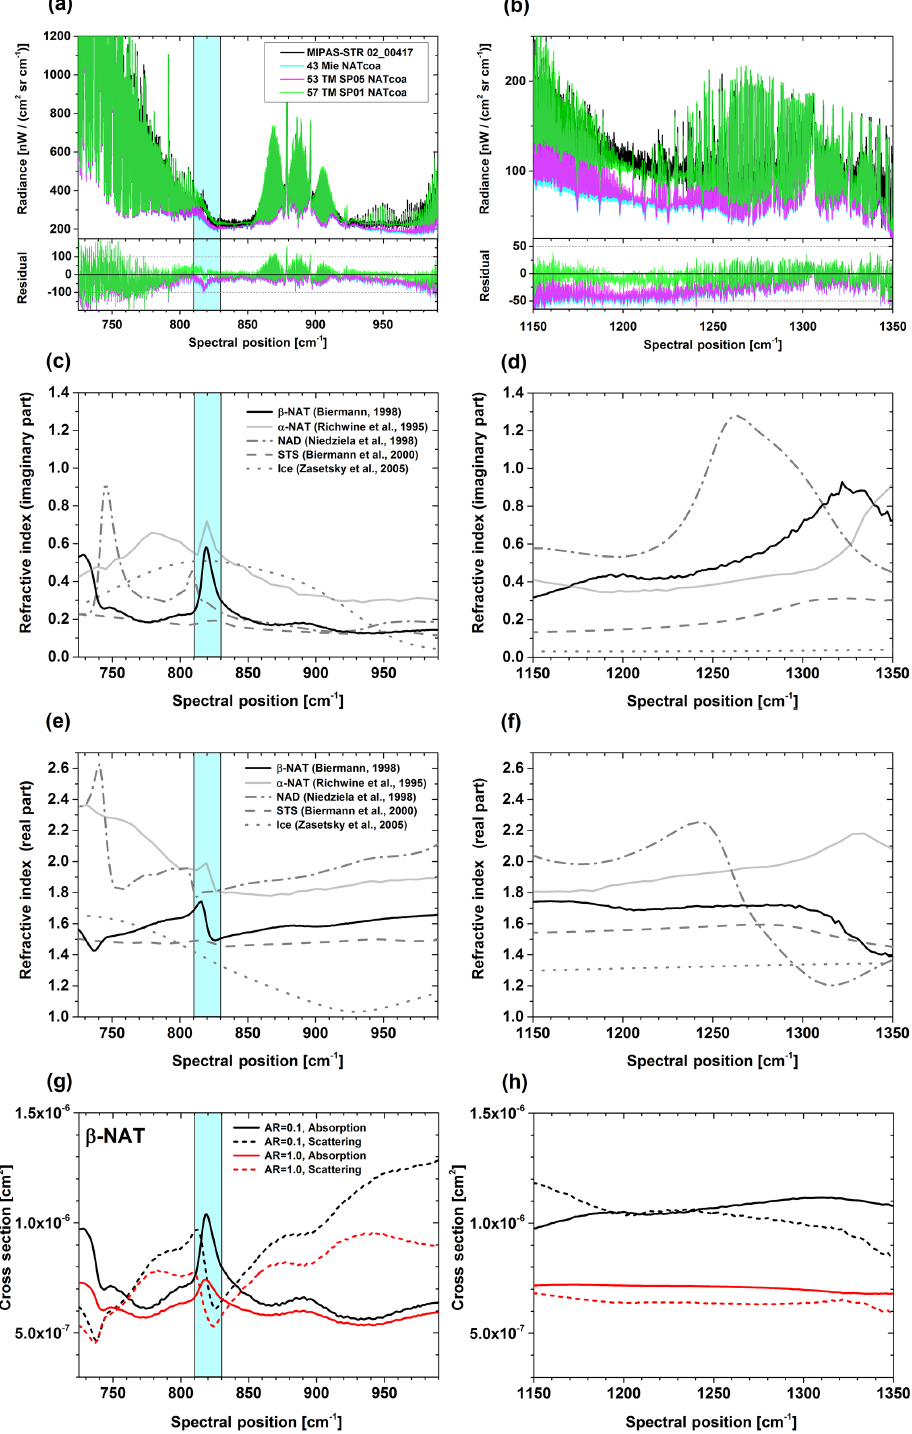
Figure 13. Dependence of simulated spectral signatures of β -NAT particles on the degree of non-sphericity. (a, b) Black: MIPAS-STR limb observation (13:47UTC, tangent altitude 18.4km). Mie calculation for spherical particles (cyan), T-Matrix calculation with AR = 0.5 (magenta), and T-Matrix calculation with AR = 0.1 (green). “NATcoa” corresponds to β -NAT, “Mie” to Mie simulation, “TM” to T-matrix simulation, and “SP” to spheroid (numbers indicate AR). Lower panels: residuals between the simulations and the observation. Numbers in the legend refer to scenarios in Table 1. Refractive index (c, d) imaginary and (e, f) real parts of β -NAT, α -NAT, NAD, STS, and ice. (g, h) Ensemble-averaged absorption and scattering cross sections of β -NAT for the discussed AR = 0.1 and AR = 1.0